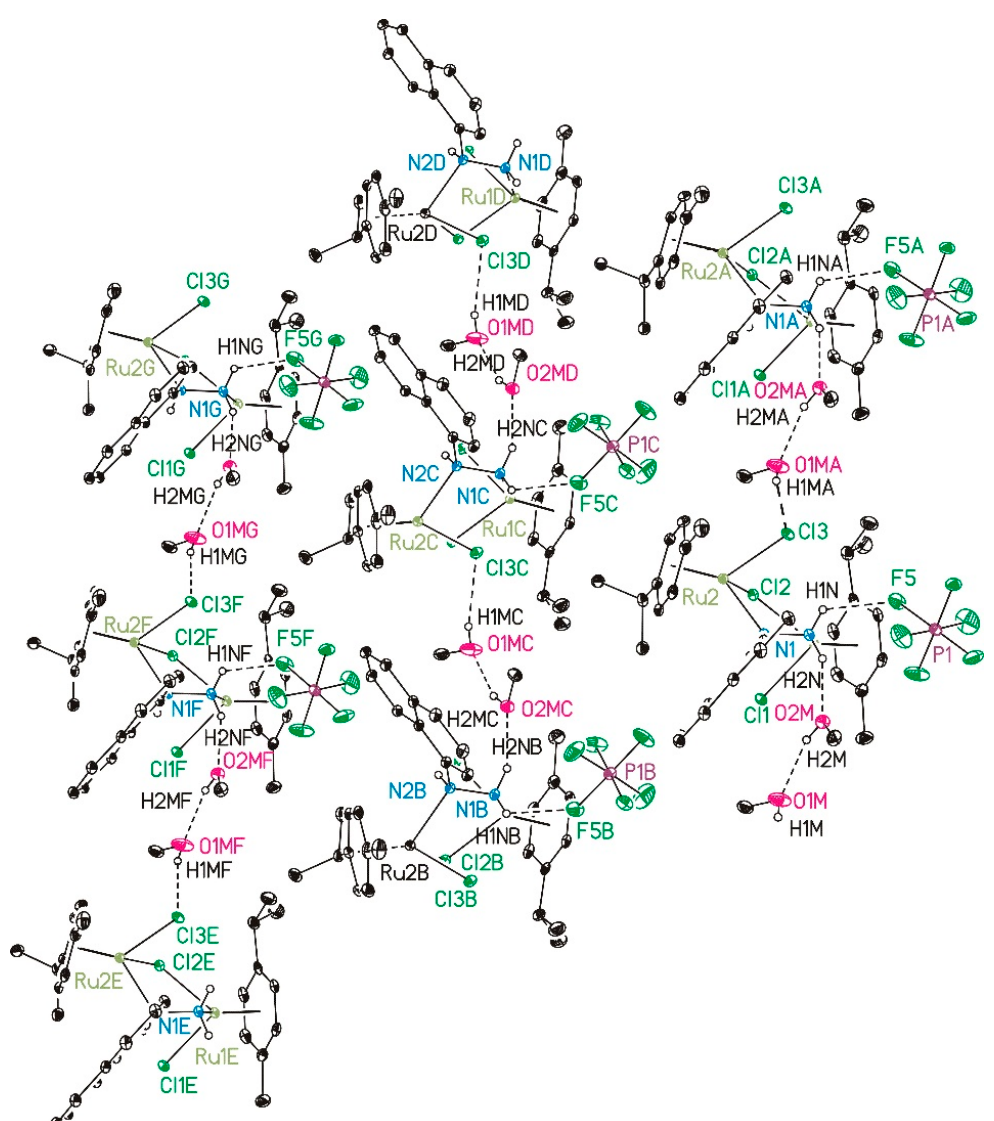
Figure 3. ORTEP (20% probability ellipsoids) of selected parts of three adjacent chains of 2·2MeOH formed in the solid state due to the formation of hydrogen bridges along the crystallographic b axes. All carbon-bonded hydrogen atoms are omitted for clarity. Dashed lines refer to hydrogen bridges.